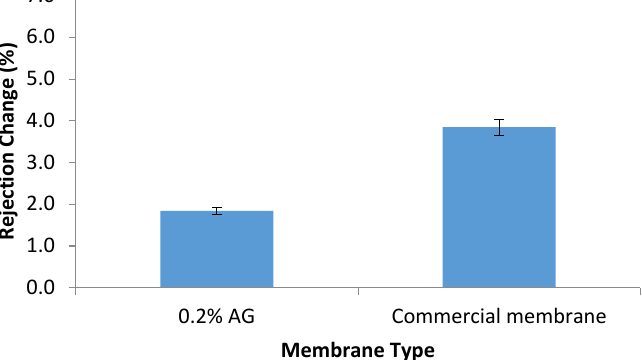
Figure 10. Change in the salt rejection of the AD commercial membrane and PA/0.2 wt.% AG membrane after immersion in 1000 ppm of NaOCl solution for 24 h.